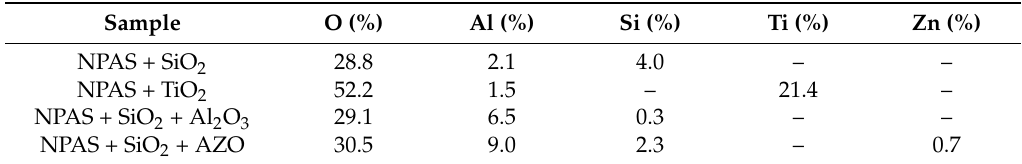
Table 2. Atomic concentration percentages (A.C.%) of the characteristic elements of each alumina-based nanoporous structure